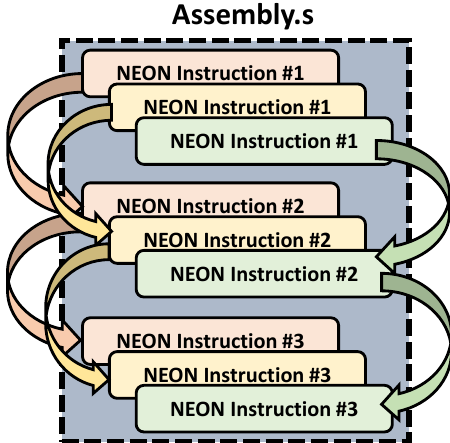
Figure 7. Interleaving the NEON instructions.